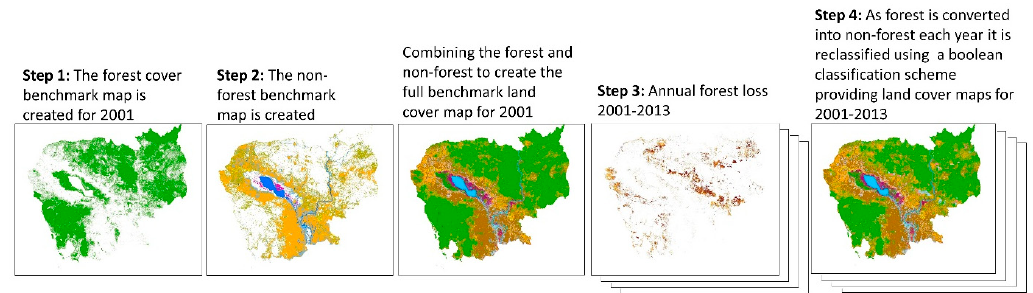
Figure 1. The general steps in the development of the land use / land cover change map for 2001 to 2013.